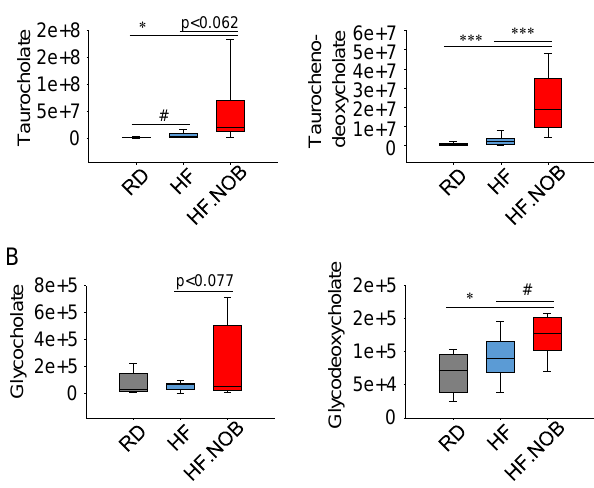
Figure4. Nobiletin(NOB)enhancesfecalbileacidexcretion. Fecaltaurine( A )andglycine( B )conjugated primary bile acid levels were measured in metabolomics ( n = 10–12). RD: regular diet; HF: high-fat diet; HF.NOB: high-fat diet with 0.1% NOB. * p < 0.05, *** p < 0.001, One-Way ANOVA; # p < 0.05, t-test. For the box and whisker plots, box edges correspond to 25th and 75th percentiles, lines inside of the box correspond to 50th percentiles and whiskers include extreme data